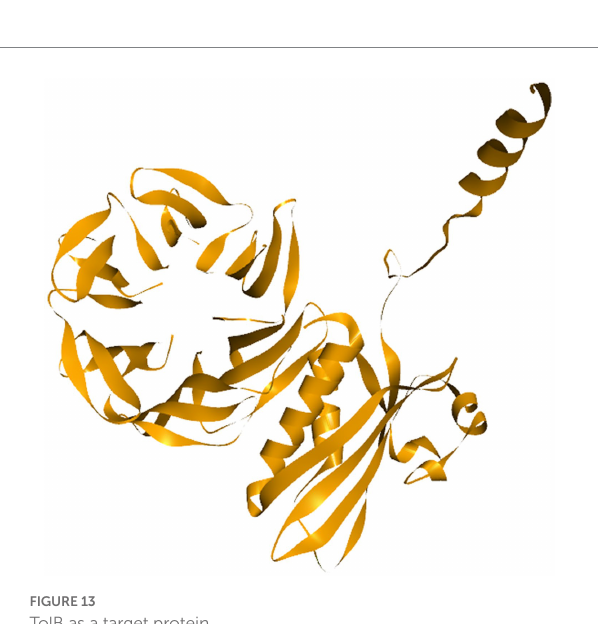
FIGURE 13 TolB as a target